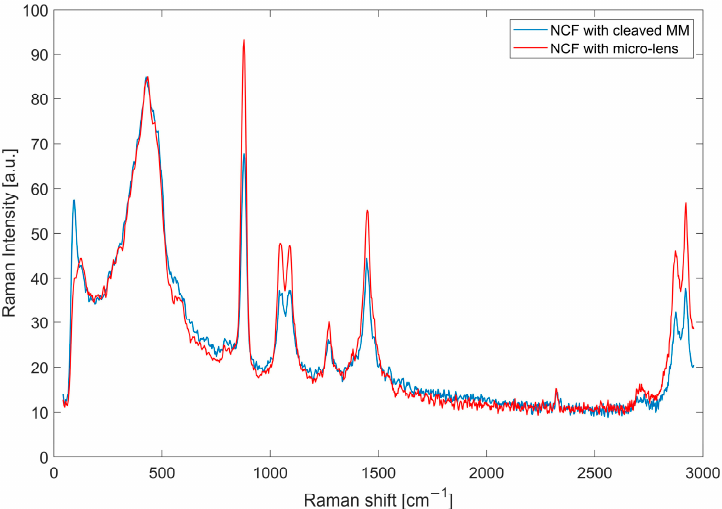
Figure 3. Collected Raman spectra of ethanol with the NCF probe with cleaved MM fibre and the NCF probe with the micro-lens. Note that the silica background around 500 cm − 1 remains constant, whereas the ethanol peaks are enhanced by the micro-lens by a factor of 1.5.